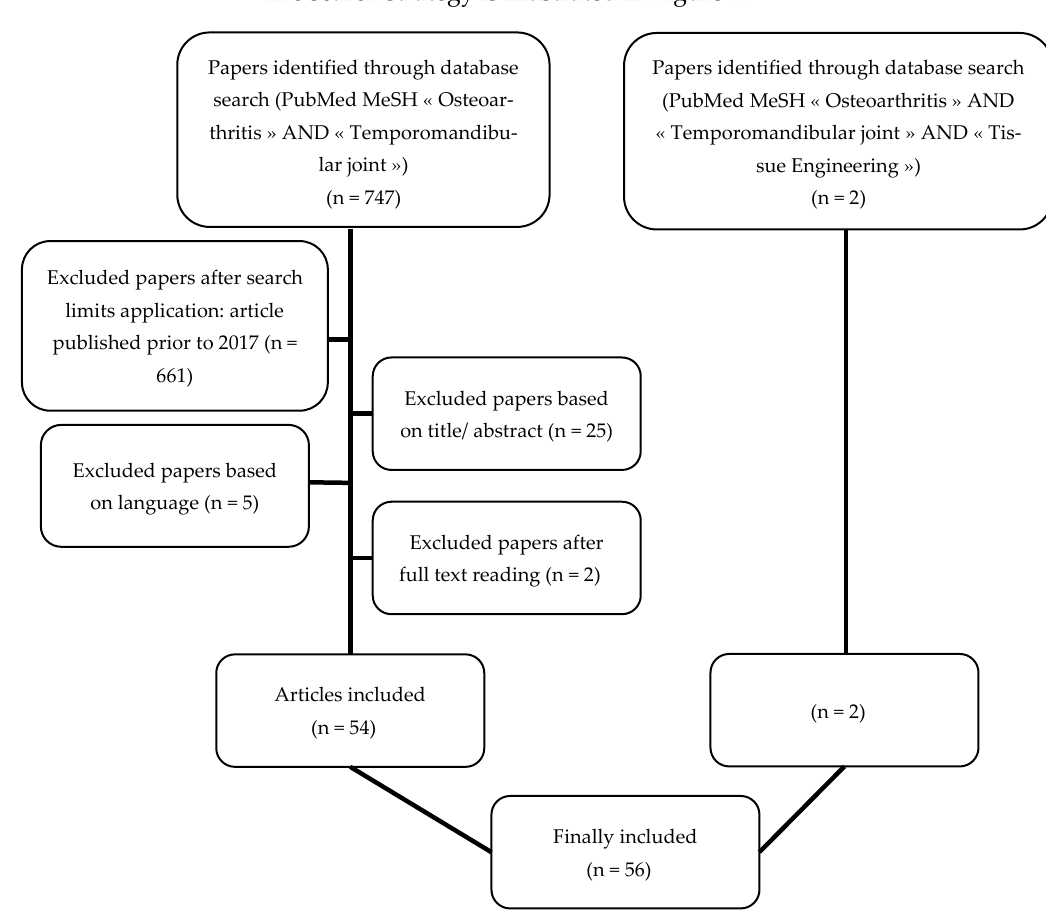
Figure 1. Flow chart of the search strategy: two searches were performed in the MEDLINE online database (PubMed). The authors initially scanned the titles and abstracts, and a second selection was made after reading the full text articles.